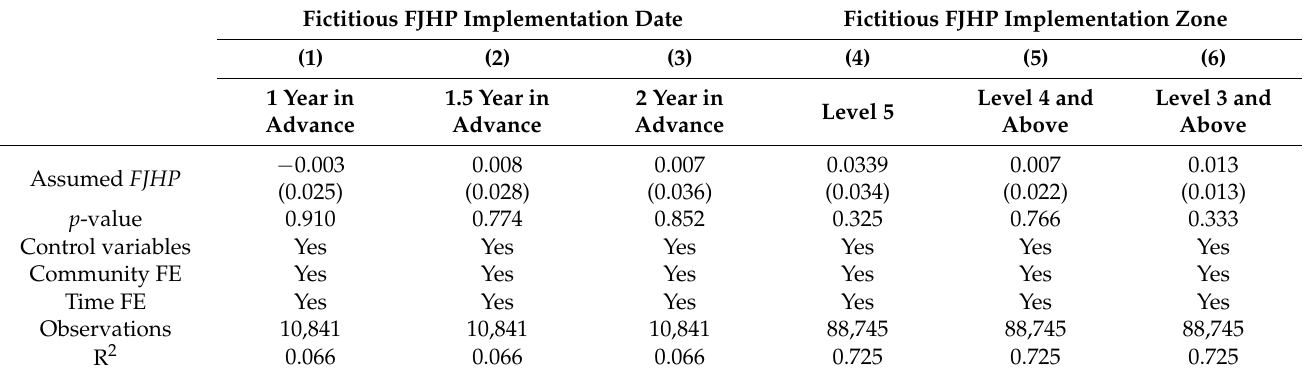
Table 5. Placebo test results for fictitious policy date and fictitious treatment